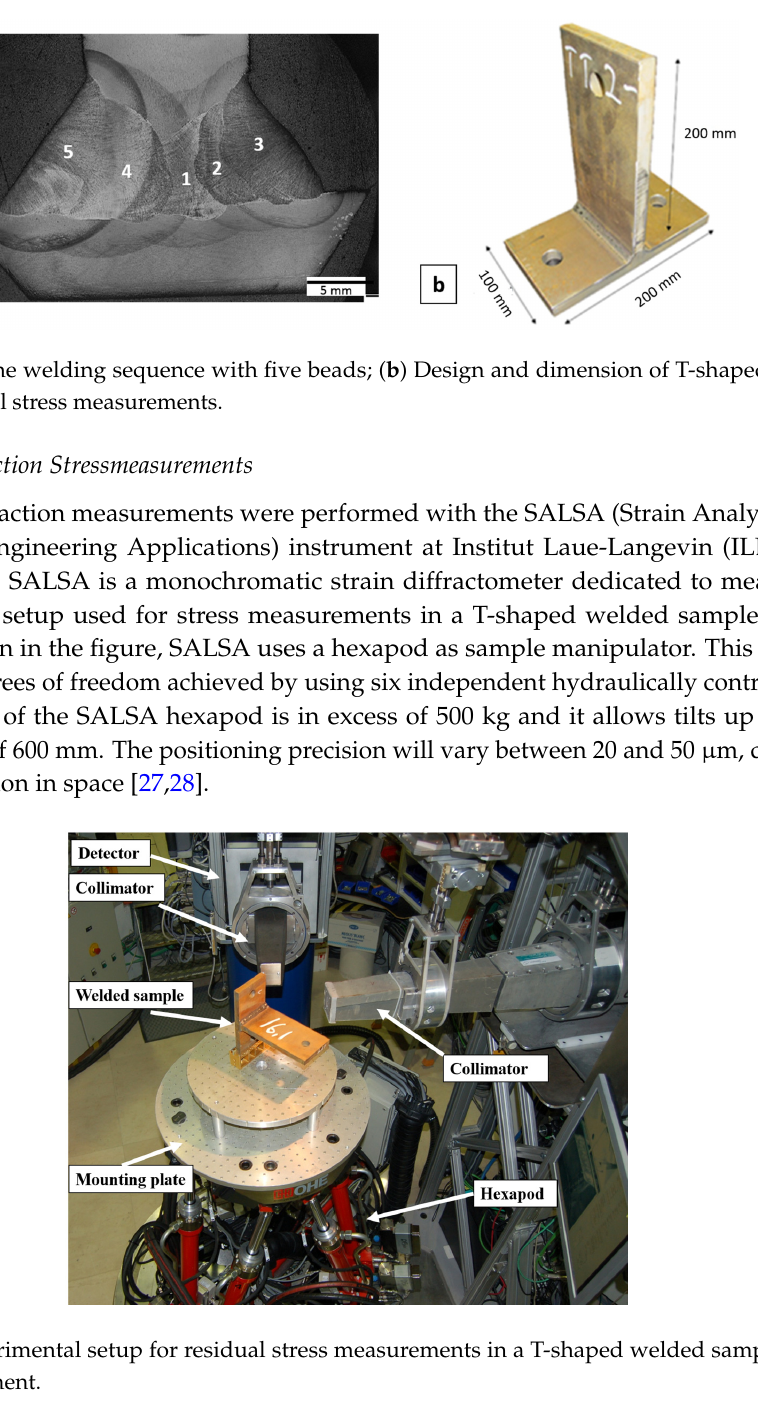
Figure 2. Experimental setup for residual stress measurements in a T-shaped welded sample in the SALSA instrument.